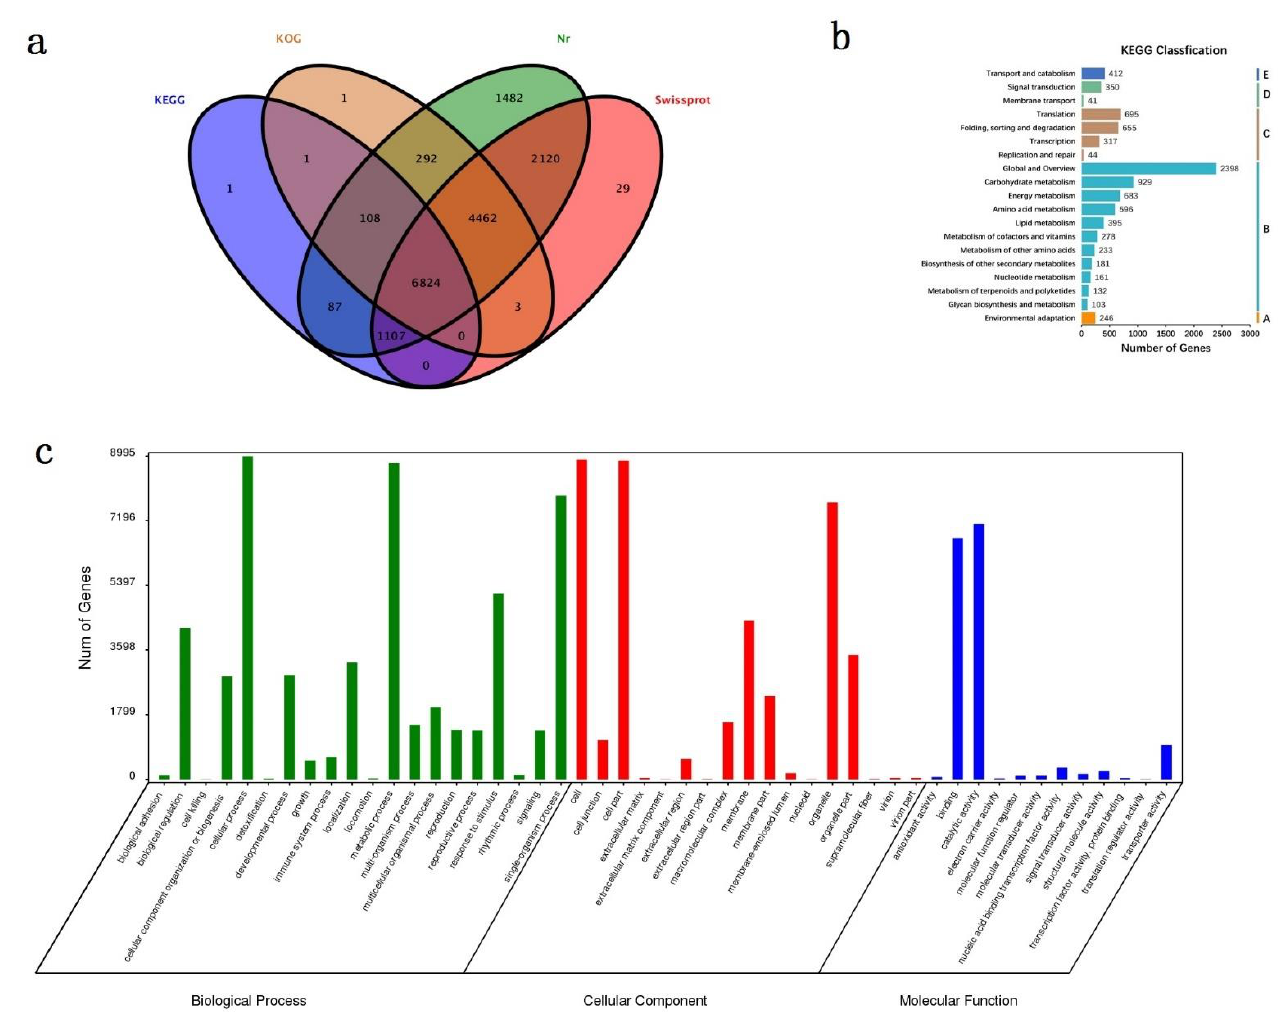
Figure 3. Gene annotation and functional classification. ( a ) Annotation information in 4 databases of the Venn diagram. ( b ) Annotation in KEGG pathway classification. The five KEGG metabolic pathways: A. Organismal Systems; B. Metabolism; C. Genetic Information Processing; D. Environmental Information Processing; E. Cellular Processes. ( c ) GO classification of all isoforms. The three main categories: biological process (BP), cellular component (CC), and molecular function (MF).